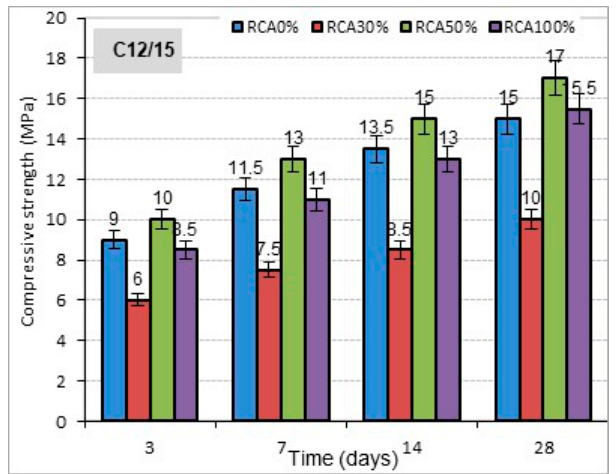
Figure 2. Compressive strength development for C12/15 concretes with various proportions of RCA.